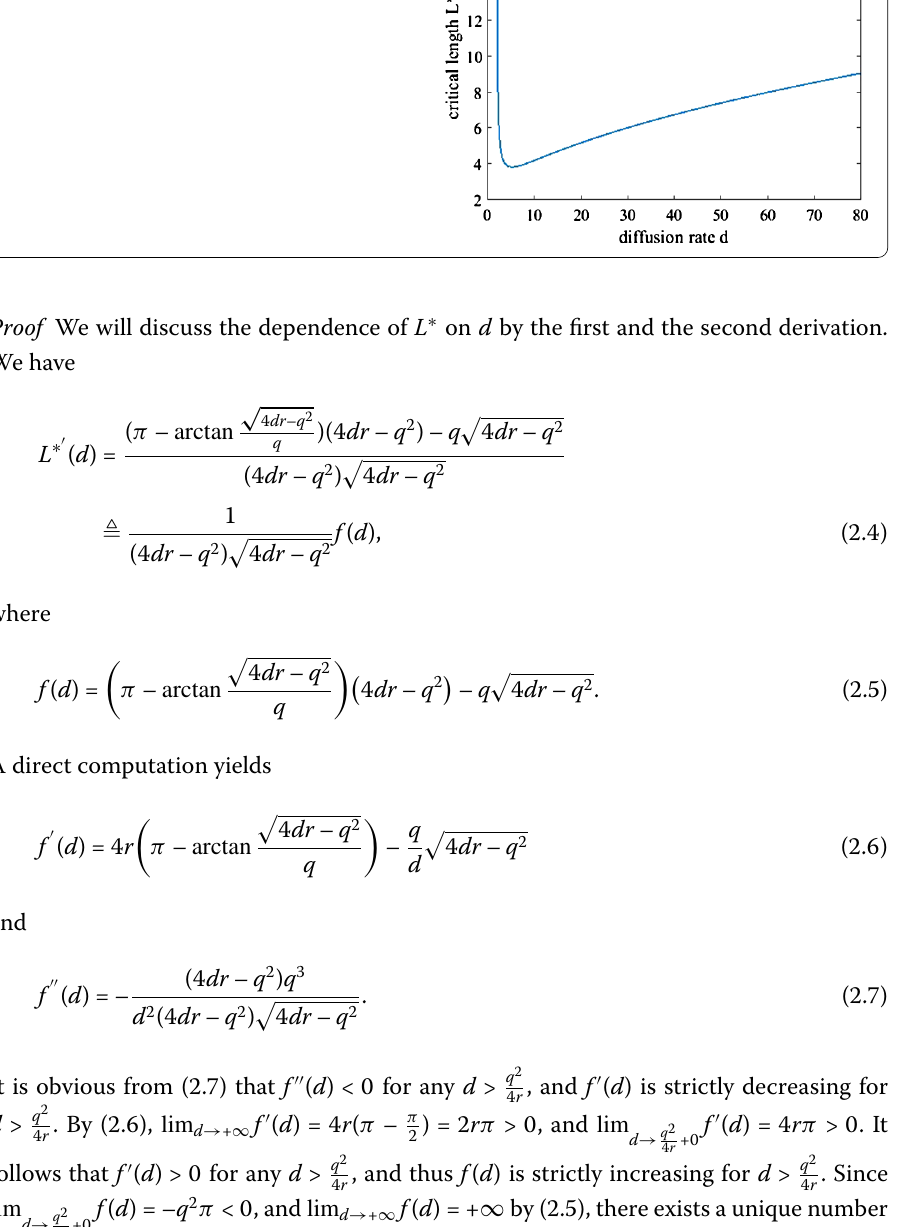
Figure 1 The critical length L ∗ of the habitat. Parameters are q = 5, r =